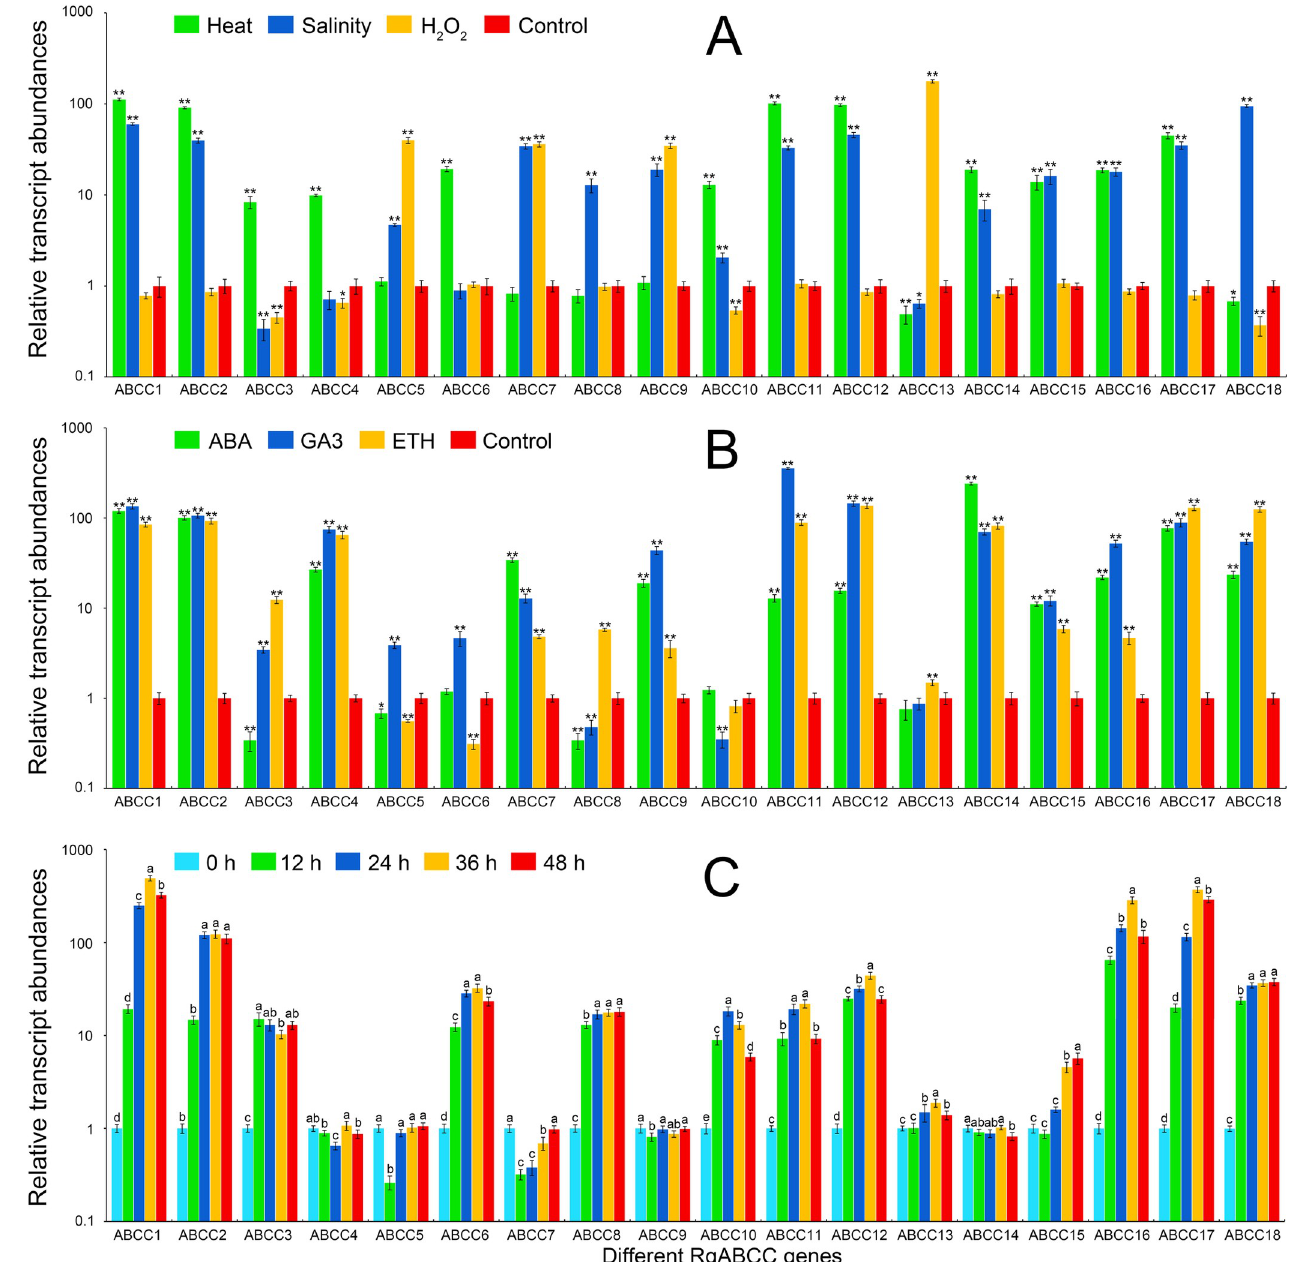
Fig 6. Transcript profiles of the RgABCCs under various conditions. (A) three abiotic stresses; (B) three hormone treatments; (C) CdCl 2 stress.